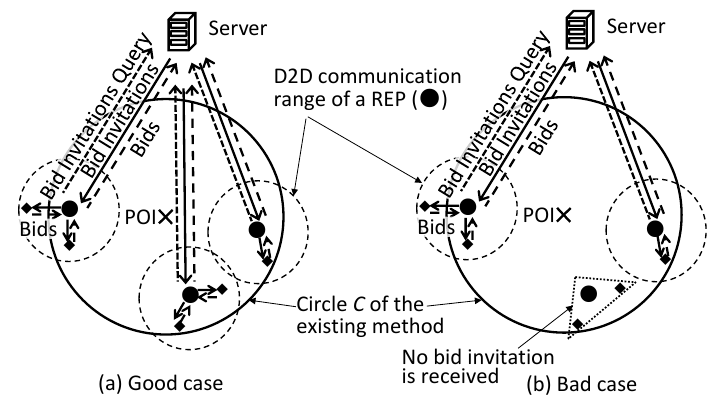
Figure 5. RevAuc procedure using D2D communication.